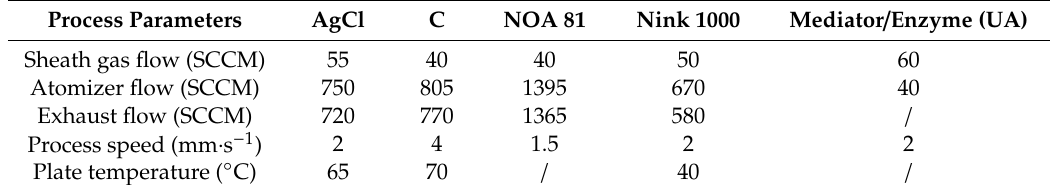
Table 1. Printing process parameters.